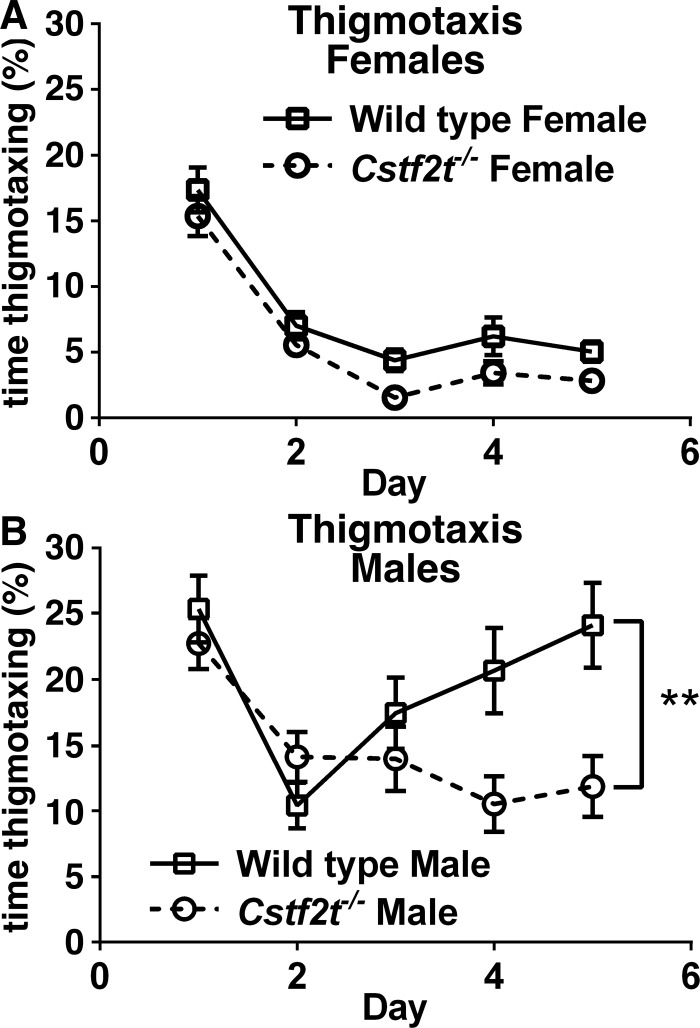
Male and female Cstf2t-/- mice show reduced thigmotactic behavior, but males show it to a greater extent.(A and B) Amount of time spent in thigmotaxis (activity while remaining near the wall), expressed as a percentage of total time. (A) Female Cstf2t-/- mice showed no difference in thigmotaxis compared to female wild type mice. (B) Male Cstf2t-/- mice showed significant reduction of thigmotaxis compared to male wild type mice (2-way ANOVA (F (3, 1328) = 59.38; p<0.0001). A post-hoc Tukey’s multiple comparison test indicated significant differences between male Cstf2t-/- mice and male wild type mice (p<0.001). All data presented as mean ± SEM. **p<0.001. ANOVA analyses were conducted using all groups.